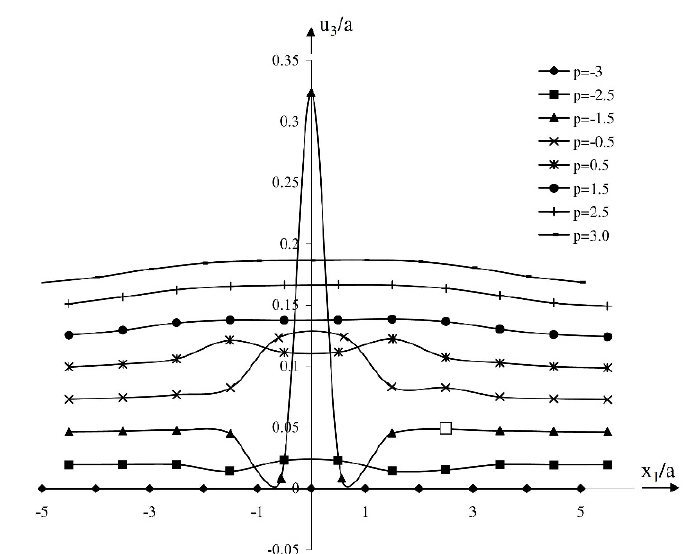
Figure 3. Lattice distortion within the (010) plane of an ultra-thin Cu film containing an OSIA at (0 , 0 , − 0 . 5 a ; 4 . 5 a ) and a vacant site at (2 . 5 a, 0 , − 0 . 5 a ; 4 . 5 a ) .